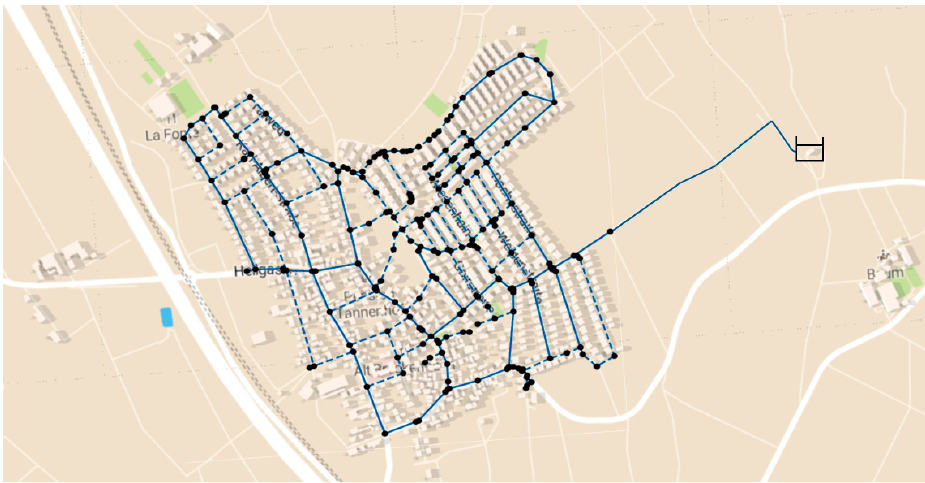
Figure 1. Existing main line water distribution system marked by solid lines and possible adaptations marked by dashed lines. Consumer and junction nodes are marked by dots and the source is marked by the tank image.